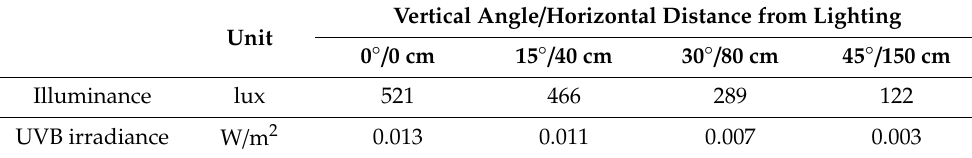
Table 1. Experiment to check the uniformity of lighting.